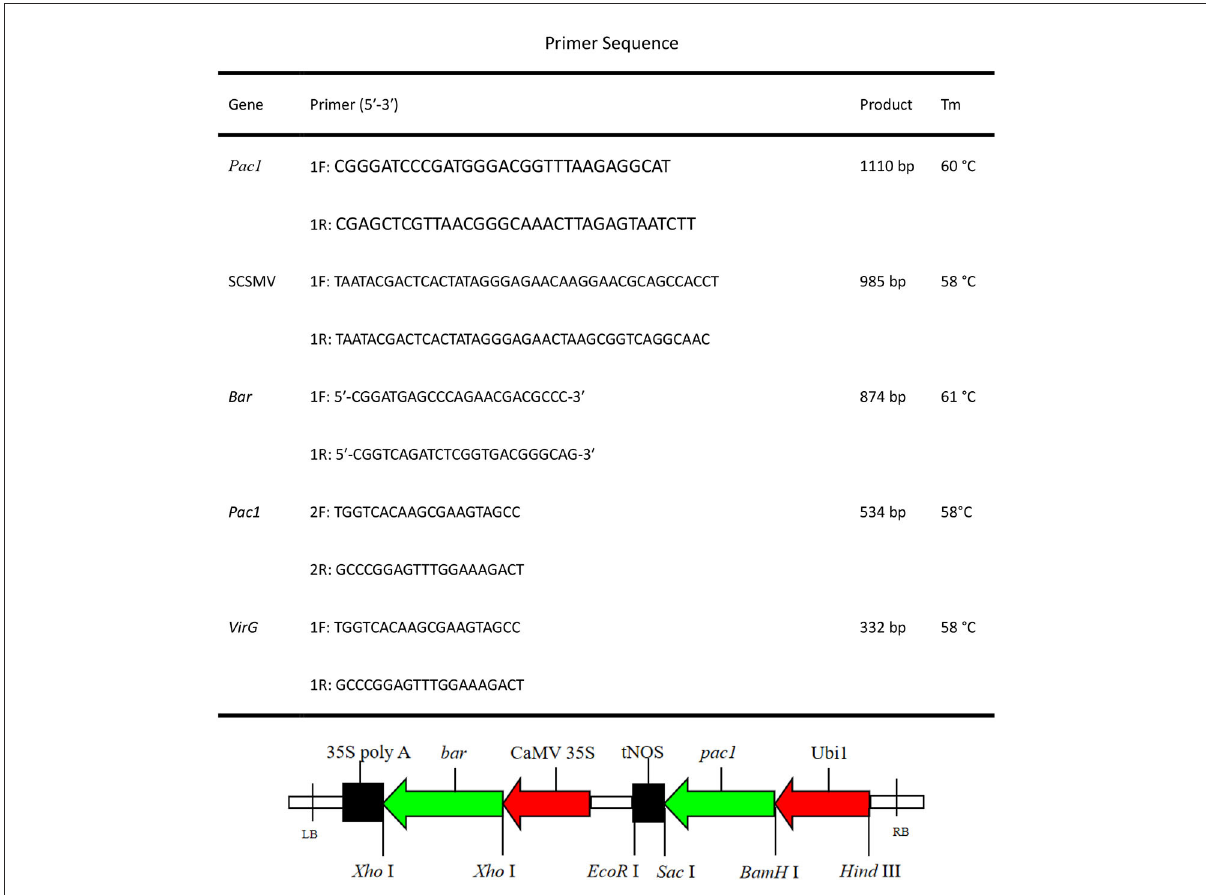
FIGURE3 Pac1 gene plant expression vector (pCAMBIA-3300-Ubi- Pac1 ). Ubi 1, maize Ubi 1 promoter; tNOS, nopaline synthase terminator; CaMV 35S, cauliflower mosaic virus 35S promoter; 35S poly A, cauliflower mosaic virus 35S poly A terminator.